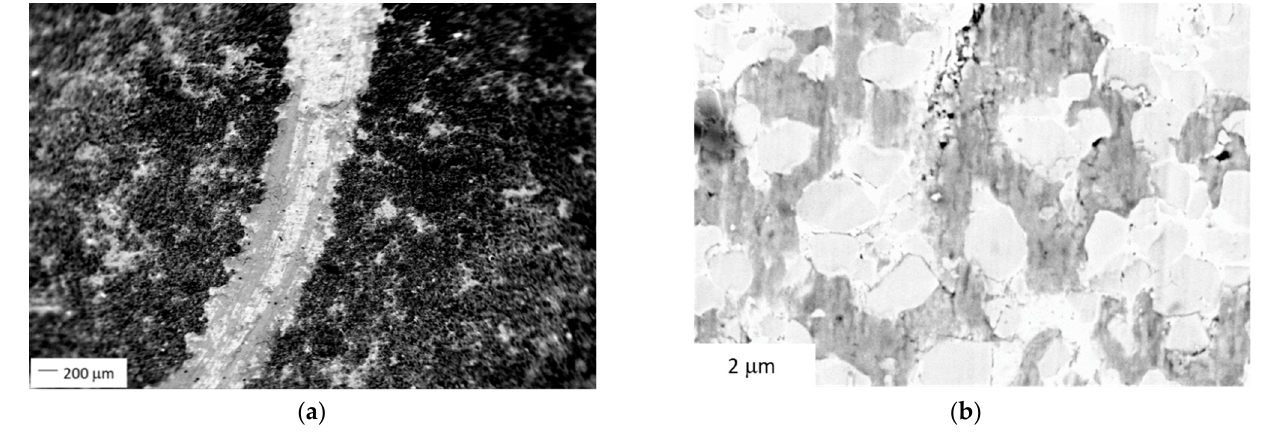
Figure 13. SEM micrograph ( a ) and a magnification ( b ) of wear tracks of Cr 3 C 2 -NiCr.